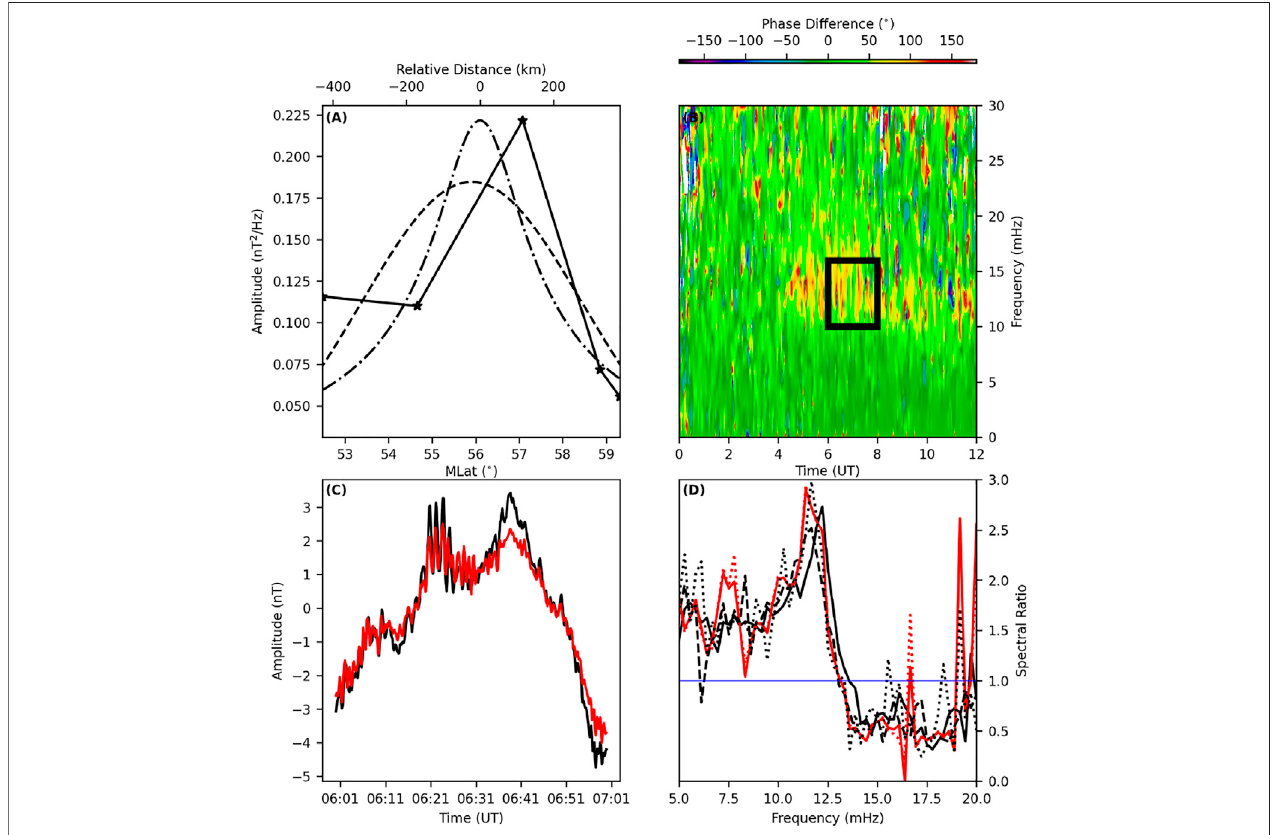
FIGURE 6 | (A) Latitudinal spectral amplitude curve fi ts; Linear piece-wise (solid, stars at station locations), Gaussian (dashed) and FLR amplitude ( Eq. 3 , dash- dotted) versus MLat/km, (B) Dynamic cross phase between RAN-OUJ, (C) Time series of the RAN (black) and OUJ (red) magnetometer stations, and (D) Spectral amplitude ratio for the boxcar (black, dotted), Hann (red, dashed), Hamming (red, solid), exponential taper (black, solid), and multi-taper (black, dashed) FFT window processing for the RAN-OUJ magnetometer data for the 19 June 2015